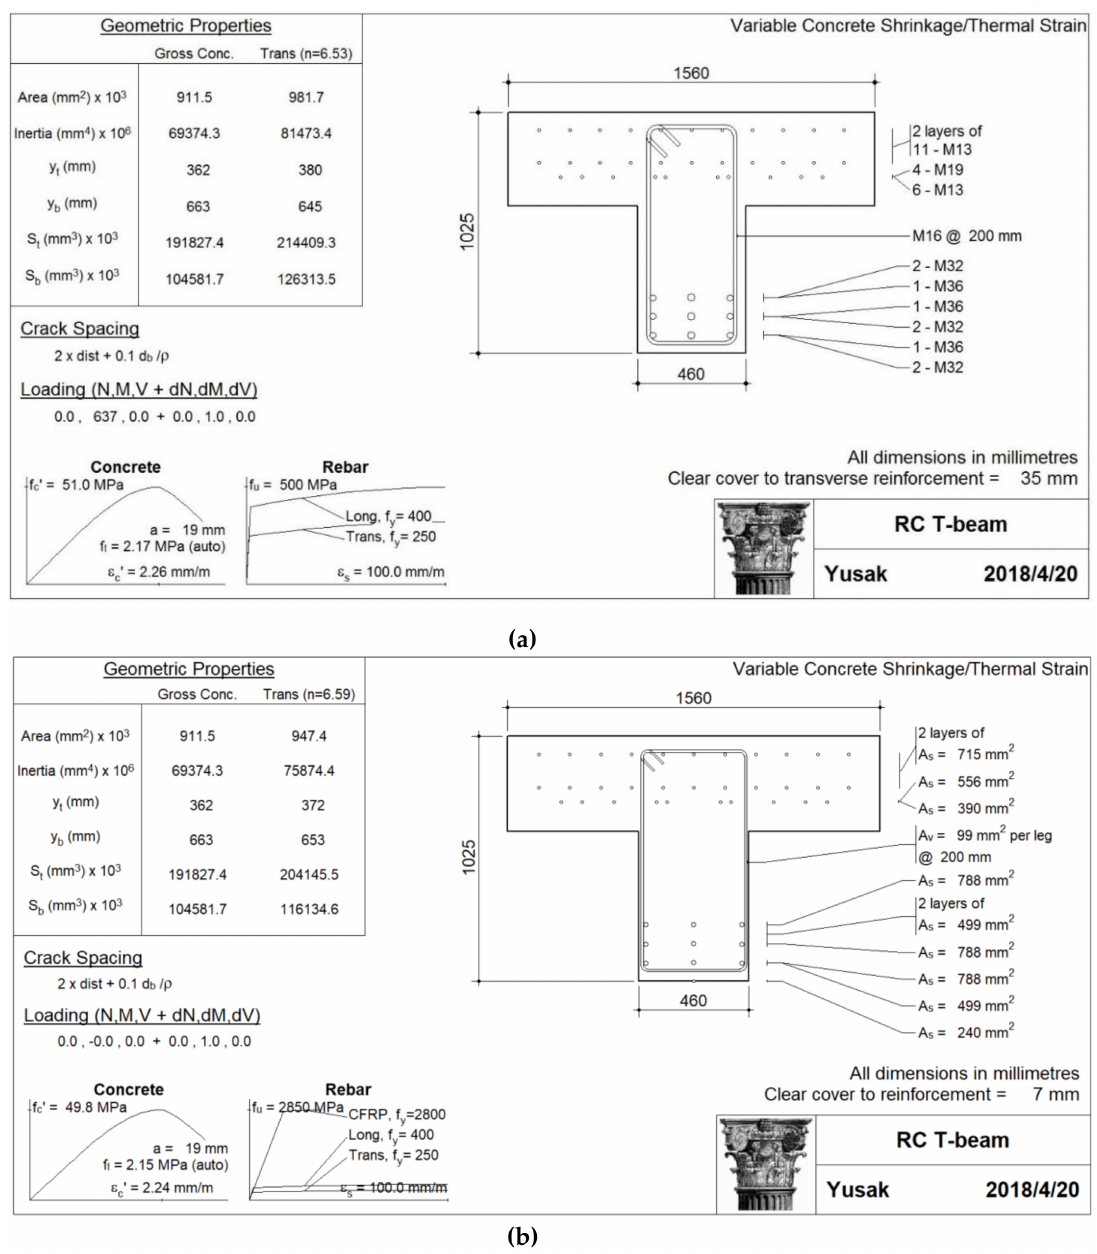
Figure 4. Input for the section analysis using Response 2000: ( a ) without CFRP; ( b ) with CFRP.